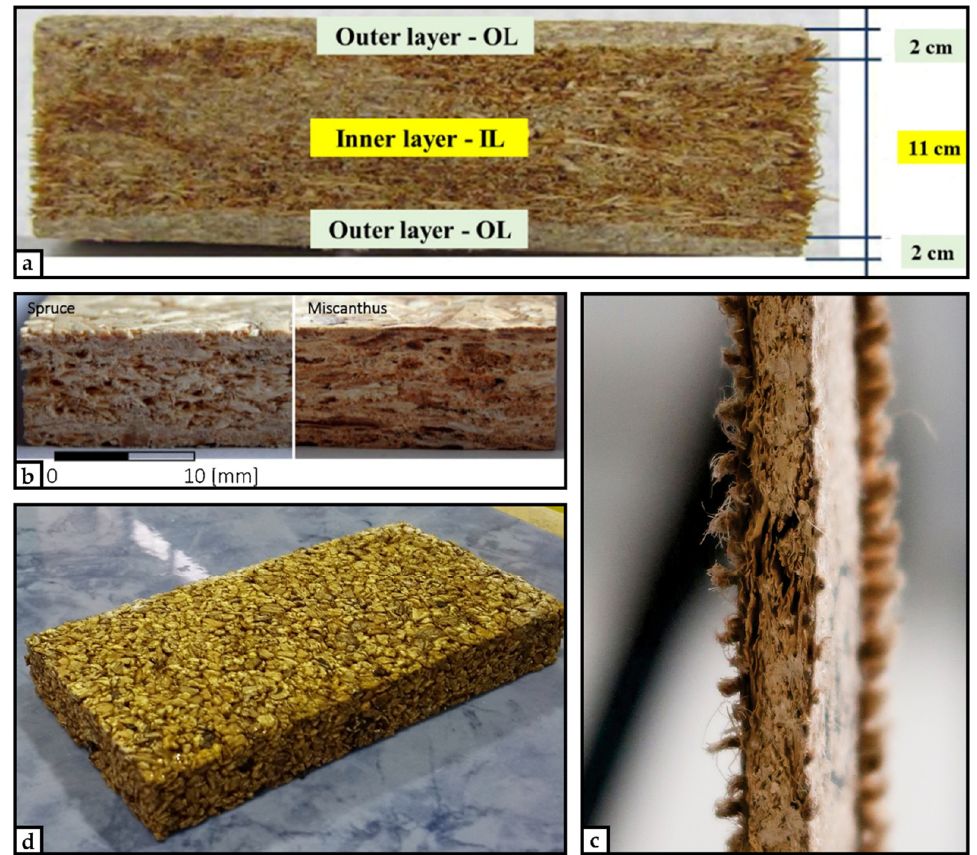
Figure 3. ( a ) three-layer particleboard with green coconut fibers in the outer layer and sugarcane bagasse in the inner layer [155], ( b ) spruce vs. miscanthus single-layer particleboards [156], ( c ) three-layer particleboard with rice husk core and a jute surface layer bonded by soybean protein [157], the ( d ) olive stone particleboard [148] .